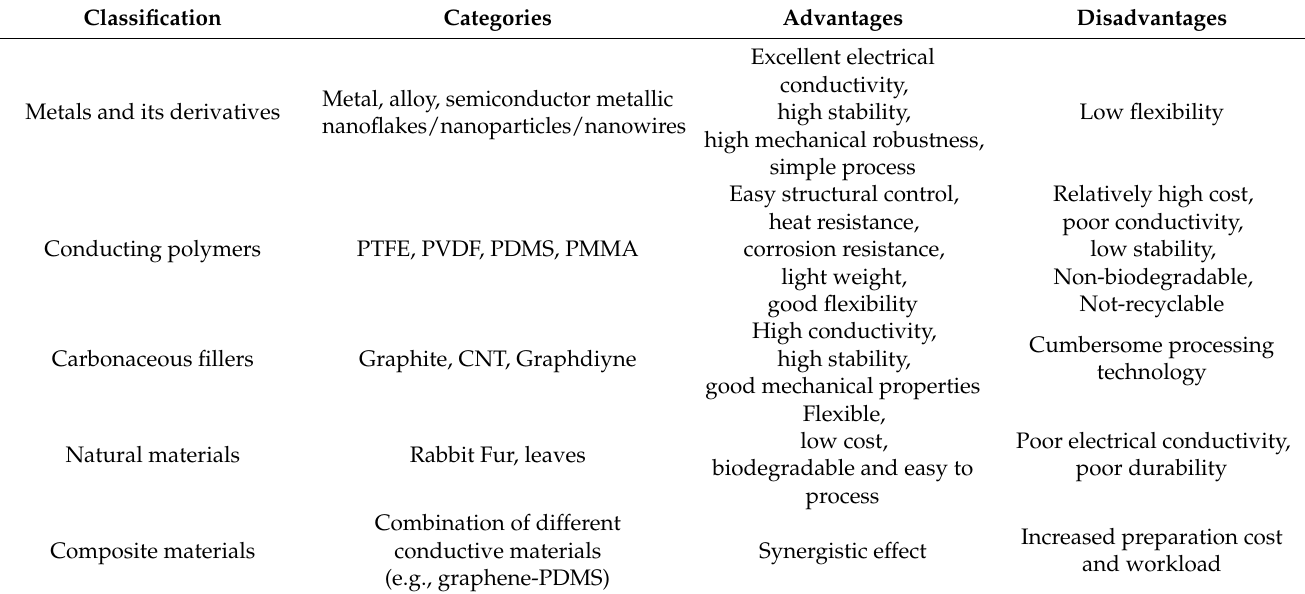
Table 1. Summary and comparison of frequently used tribo-active materials for